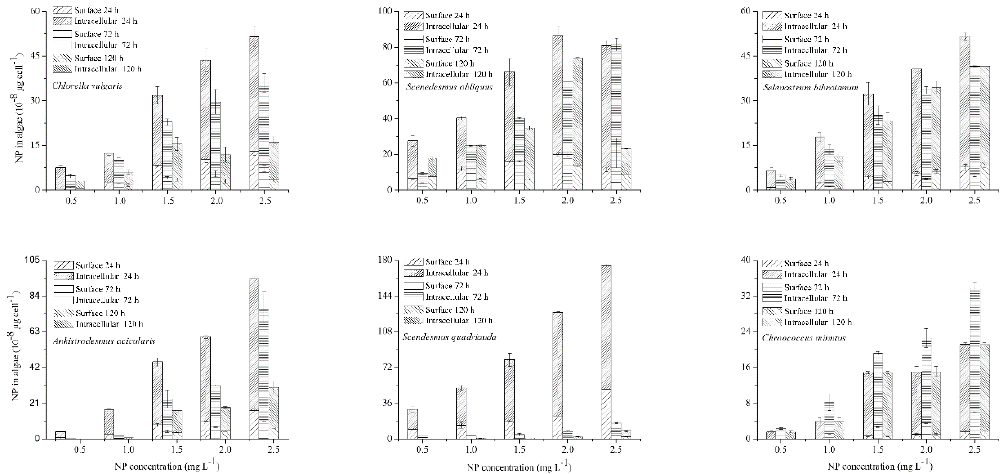
Figure 5. NP accumulation in microalgae. Algae were treated with NP at 0.5–2.5 mg L − 1 culture for 120 h. Values are the mean ± standard deviation (SD) ( n = 3).